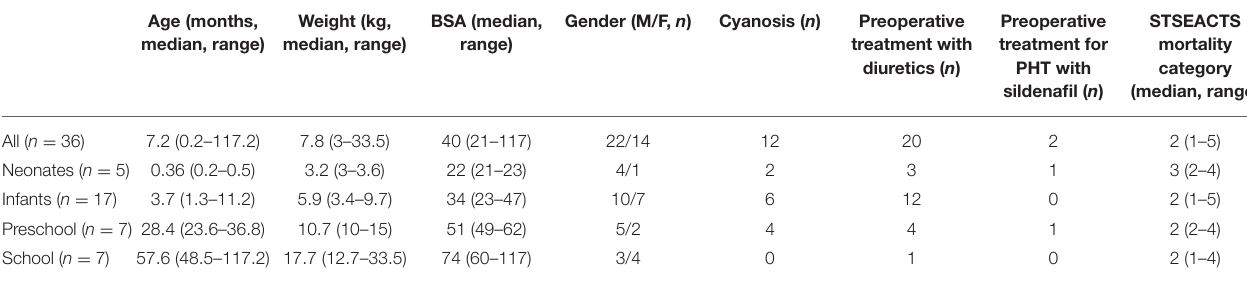
TABLE 2 | Patient demographics.